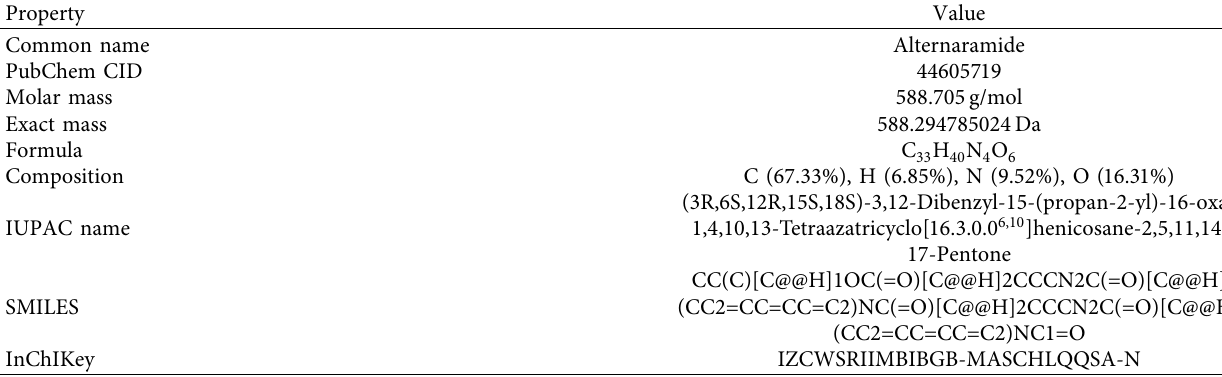
Table 1: Names, identifiers, and basic properties of the studied molecular system.